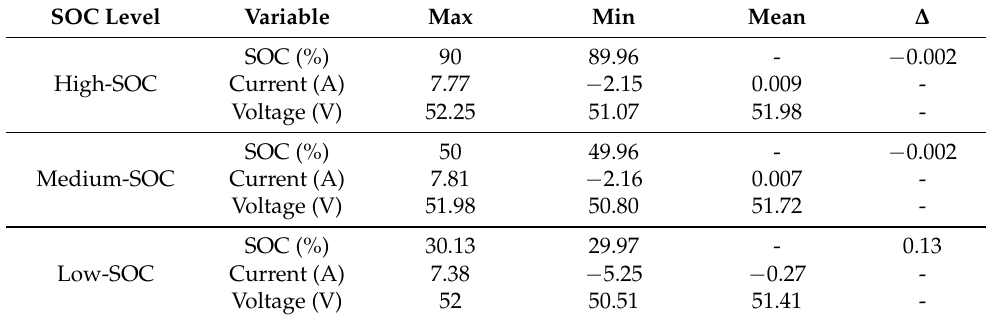
Table 6. Battery response in high, medium and low SOC semi-active hybrid simulation.